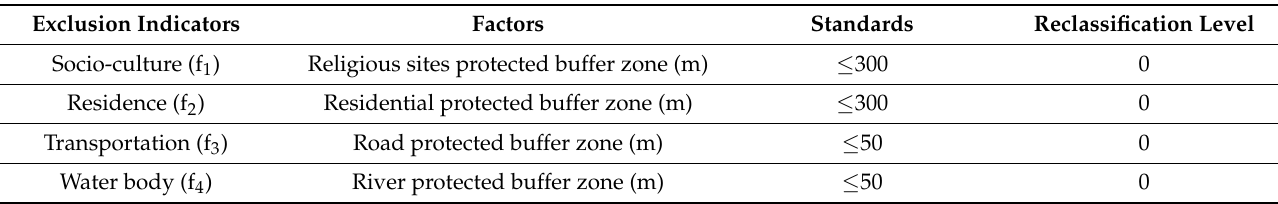
Table 1. The standards of exclusion